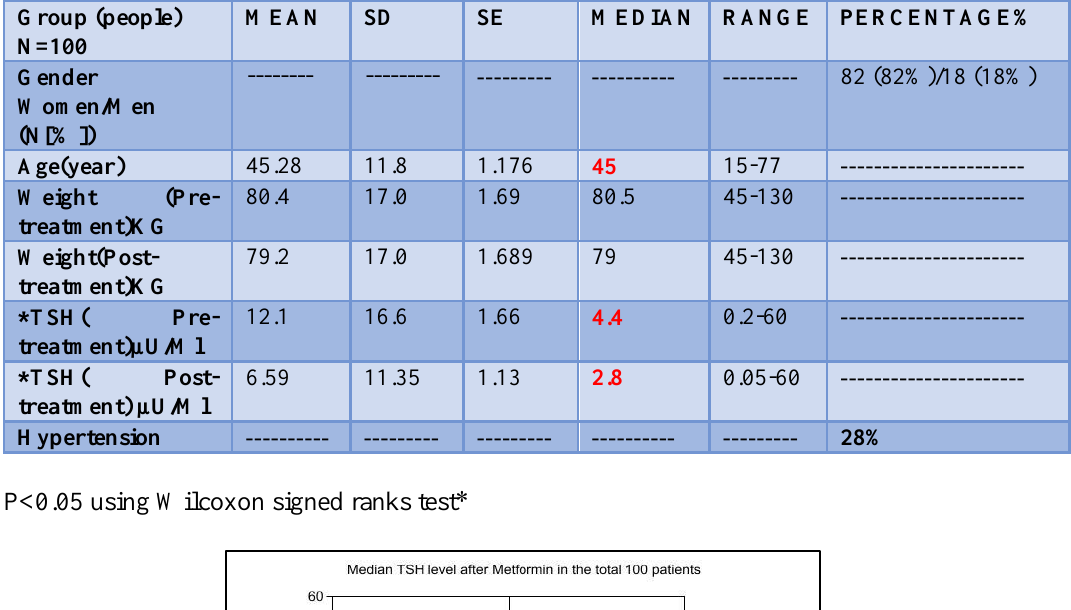
Table 1: shows the demographic data with the change in TSH and weight before and after metformin therapy in the total 100 patients .